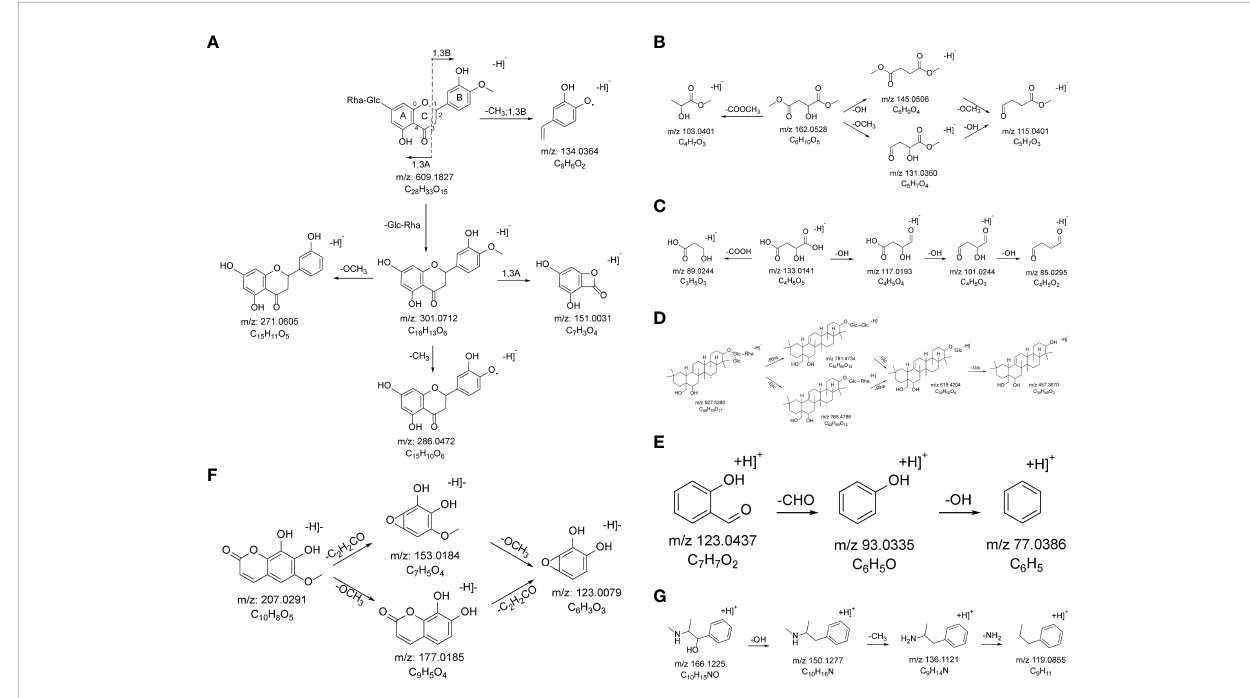
FIGURE 3 The probable MS fragmentation process of Hesperidin (A) , Dimethyl L-malate (B) , (2S)-2-Hydroxybutanedioic acid (C) , Saikosaponin F (D) , Salicylaldehyde (E) , Fraxetin (F) , and Pseudoephedrine (G)